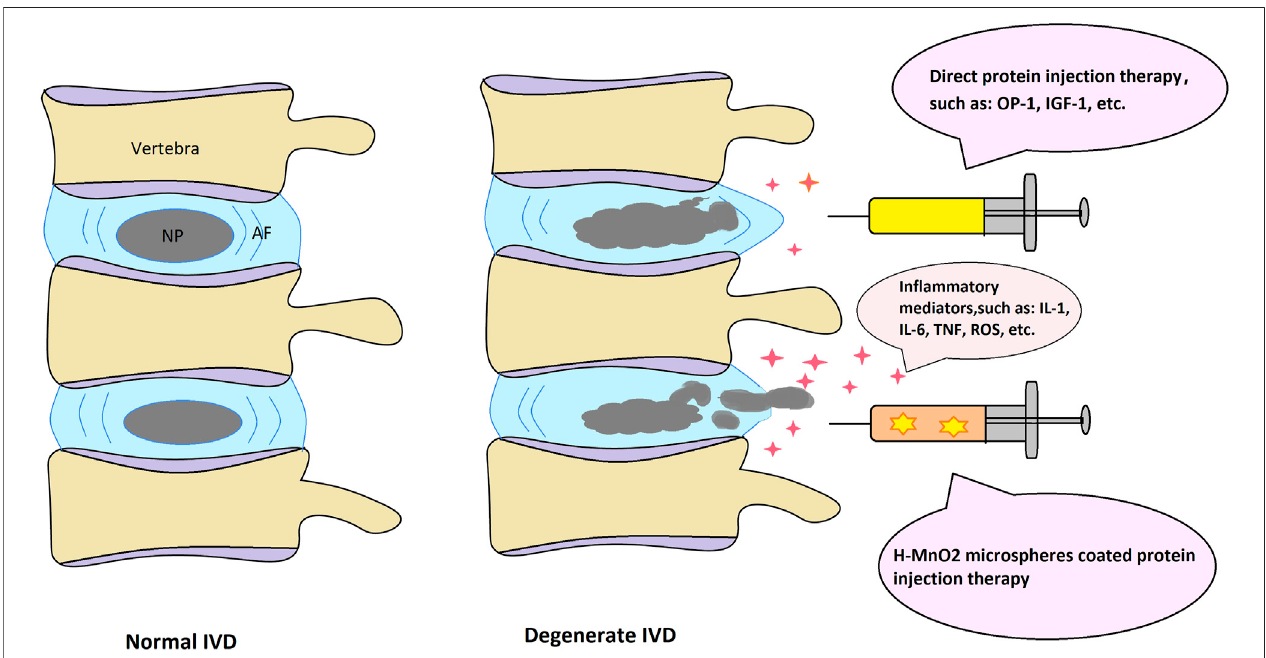
FIGURE 2 | Schematic depiction of the normal and degenerate IVD structure with possible protein injection therapeutic approaches.